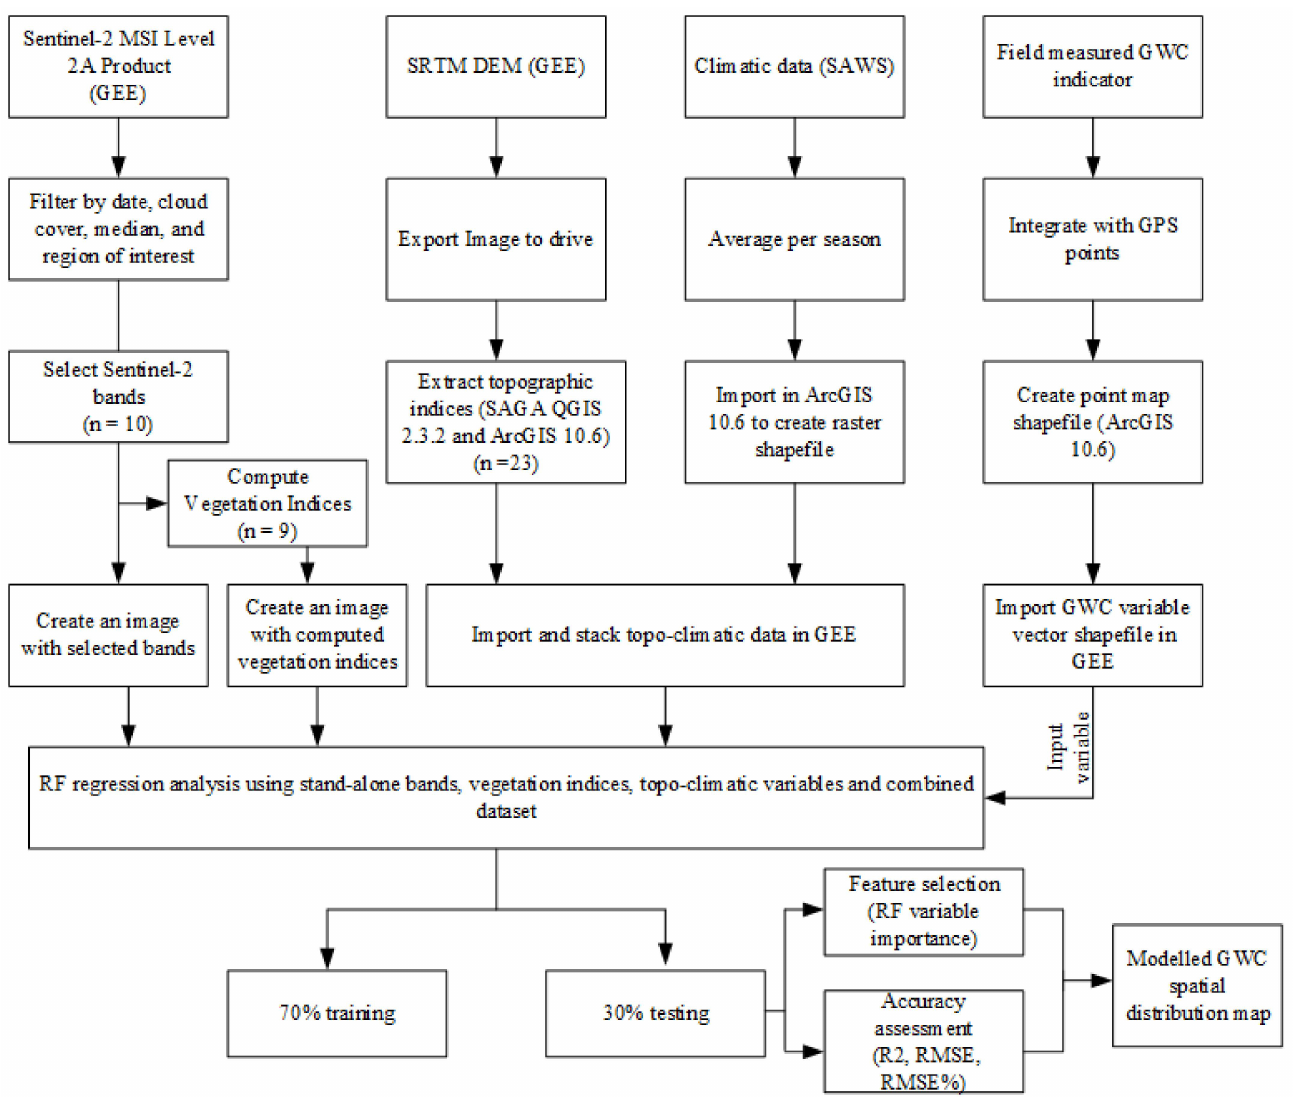
Figure 2. Research methodology work chart used on each GWC variable across wet and dry